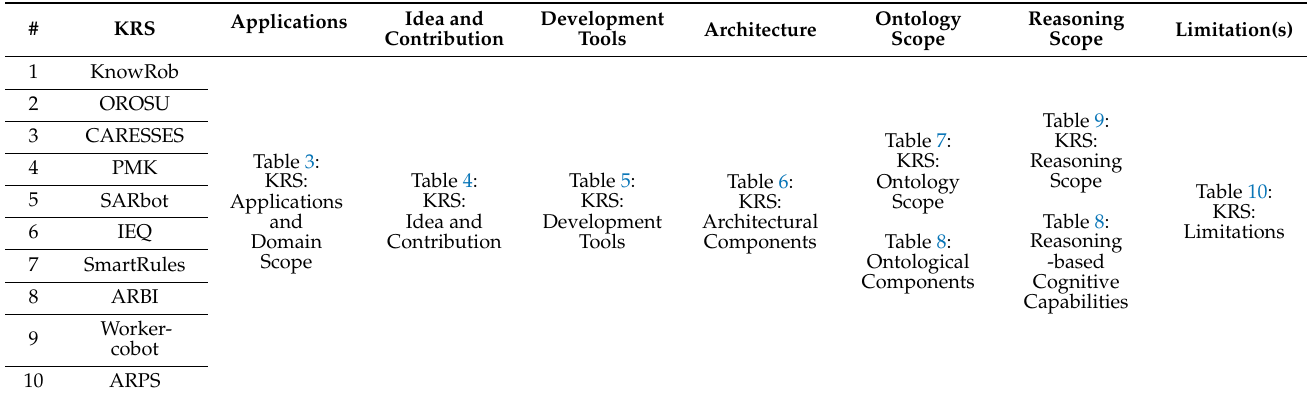
Table 11. Summary of the evaluation results of ontology-based knowledge representation systems in seven